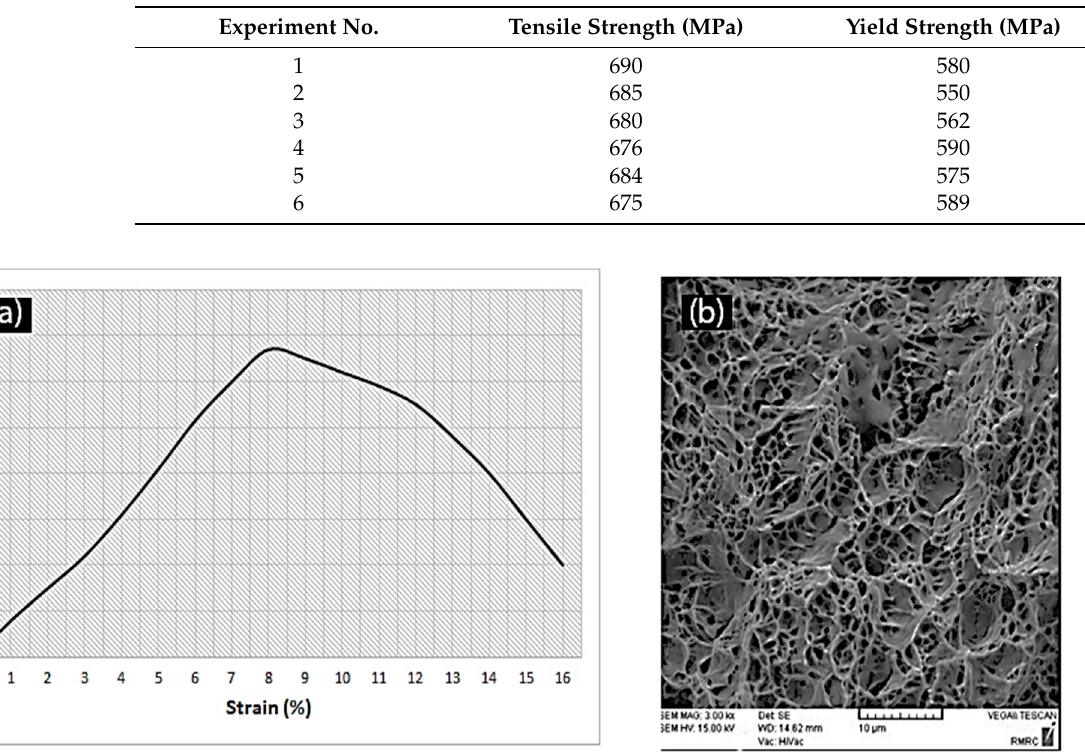
Figure 7. ( a ) Stress–strain curve of welded joint with a heat input of 2.33 kJ/mm, ( b ) SEM image of the fracture surface of 2.33 kJ/mm sample indicating ductile